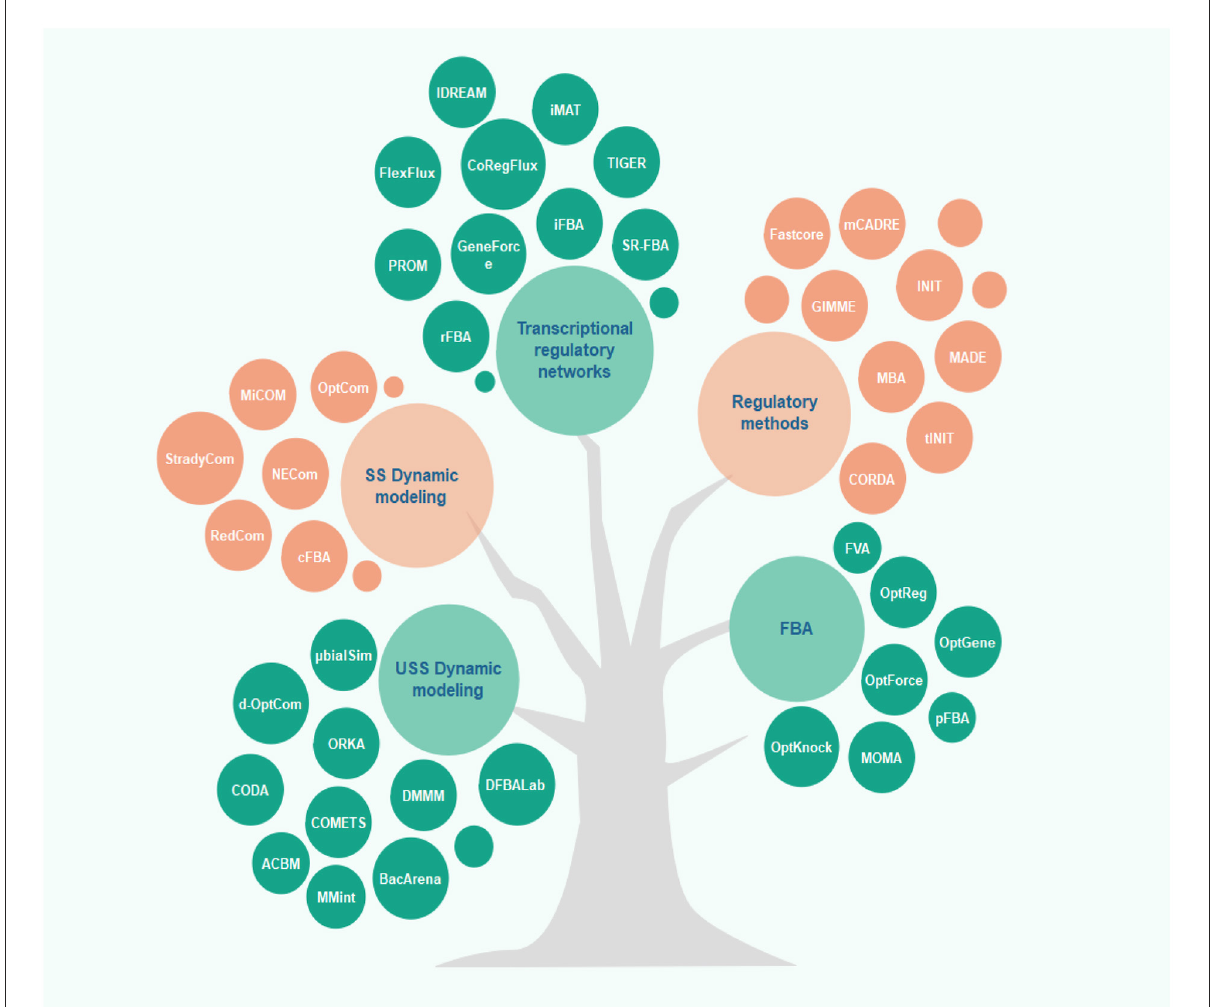
FIGURE2 Overview of different algorithms used in microbiome-cardiovascular disease studies. Several constraint-based models have been proposed to predict and analyze the metabolic behavior of cells in recent years. This figure depicts these methods classified based on their applications and underlying algorithms (for more details, see the Supplementary